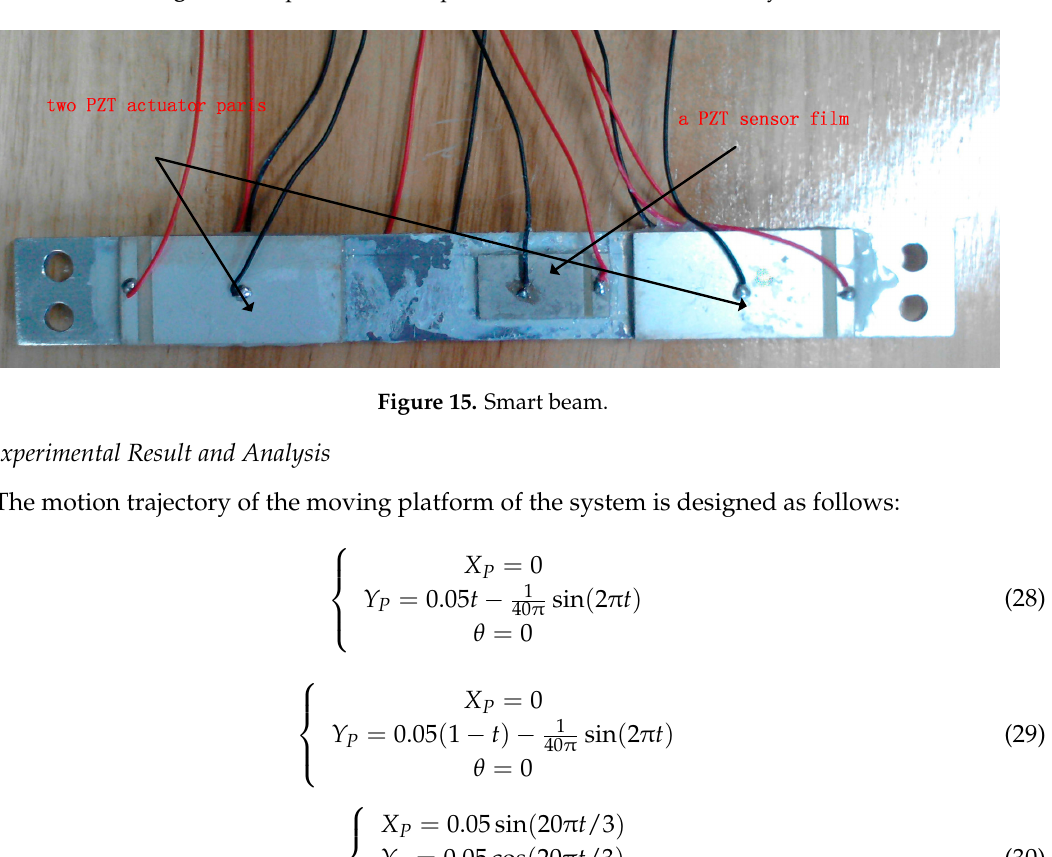
Figure 14. Experimental setup of the active vibration control system.